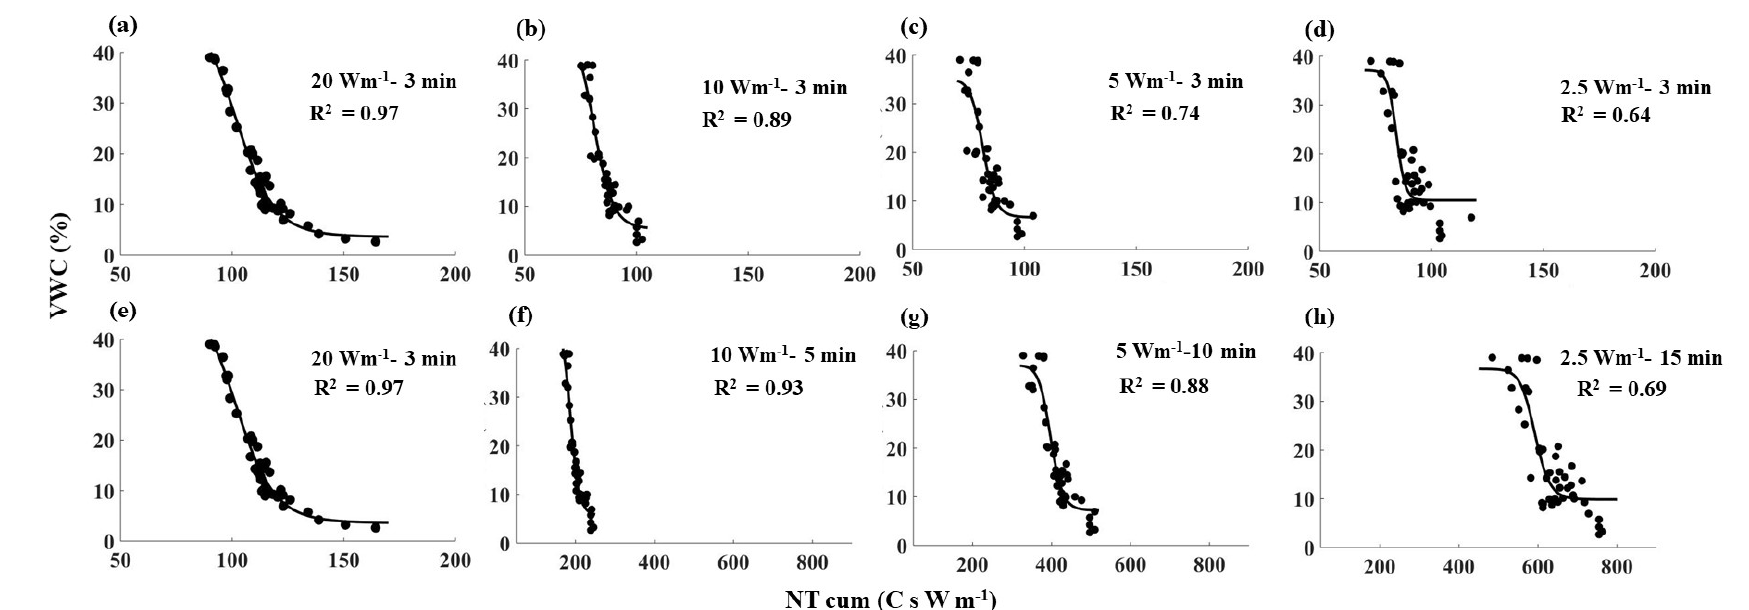
Figure 7. NT cum as a function of VWC for all the heating strategies tested in clay loam soil. The black dots show the observed values, and the black solid lines show the fitted relationships between NT cum and VWC for individual heating strategies. Note: ( a , e ) are similar (20 Wm − 1 –3 min) and are used to compare with the short pulses (along row 1) and with the long pulses (along row 2).